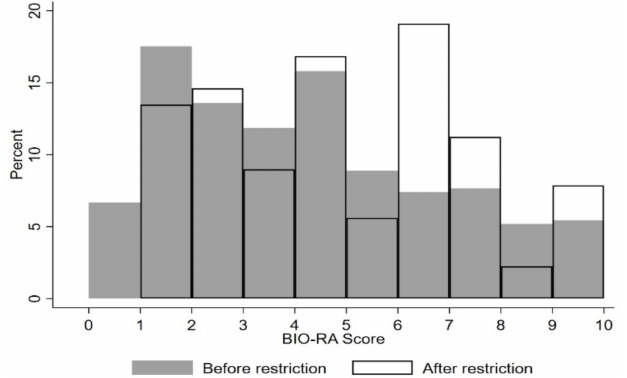
Figure 1. The BIO-Ra scores distribution before and after EMA restrictions. Each column describes the frequency of the corresponding BIO-Ra score in the study cohort. Full and empty columns correspond to patients enrolled before and after EMA restrictions,